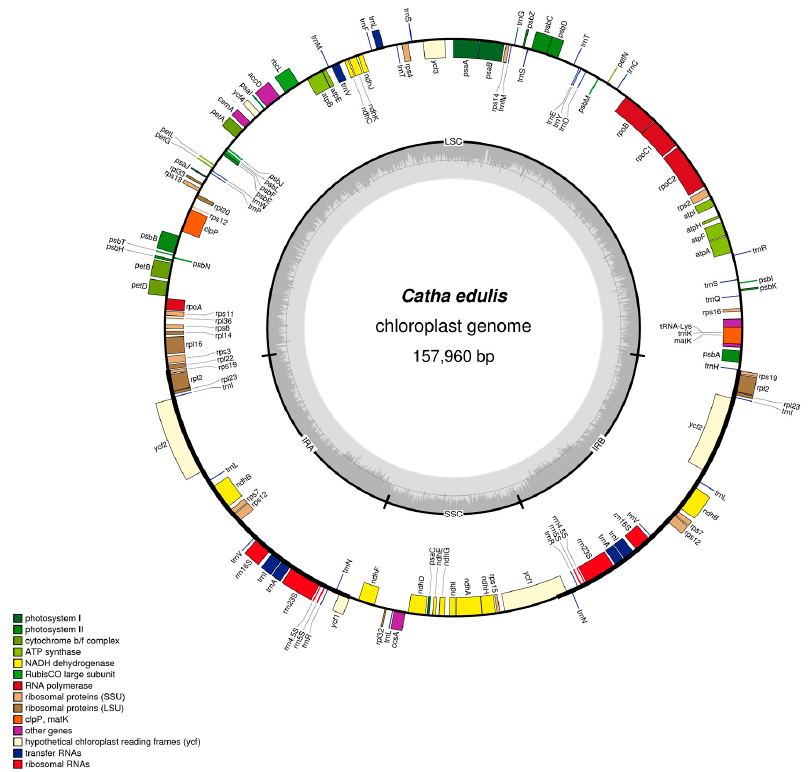
Figure 1. Circular map of the C. edulis cp genome. Genes shown inside and outside of the outer circle are transcribed clockwise and counterclockwise, respectively. The innermost shaded area inside the inner circle corresponds to GC content in the cp genome. Genes in different functional groups are color coded. IR, inverted repeat; LSC, large single copy region; SSC, small single copy region. The map is drawn using OGDRAW (V 1.2, Max Planck Institute of Molecular Plant Physiology, Am Mühlenberg, Germany).